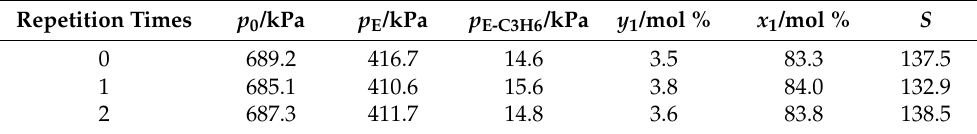
ZIF-8/glycol-water slurries where the mass ratio between water and glycol in the solution was